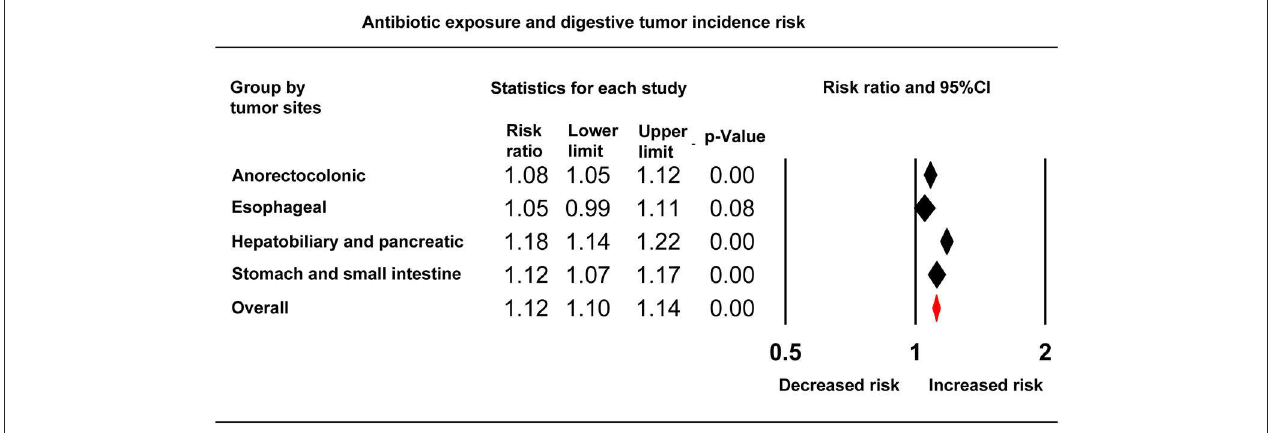
FIGURE 2 | Forest plot showing the relationship between whole anti-bacterial drug exposure and digestive system cancer risks grouped by tumor site.